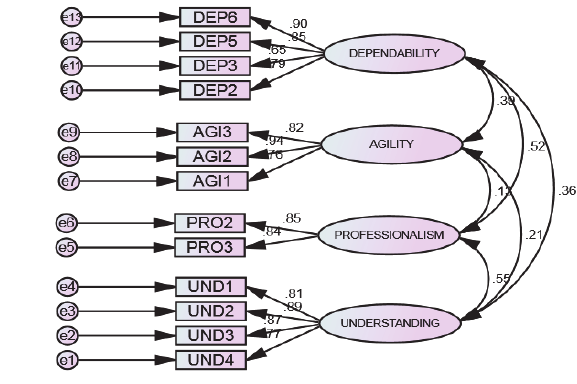
Fig. 4. CFA Model Development for measuring